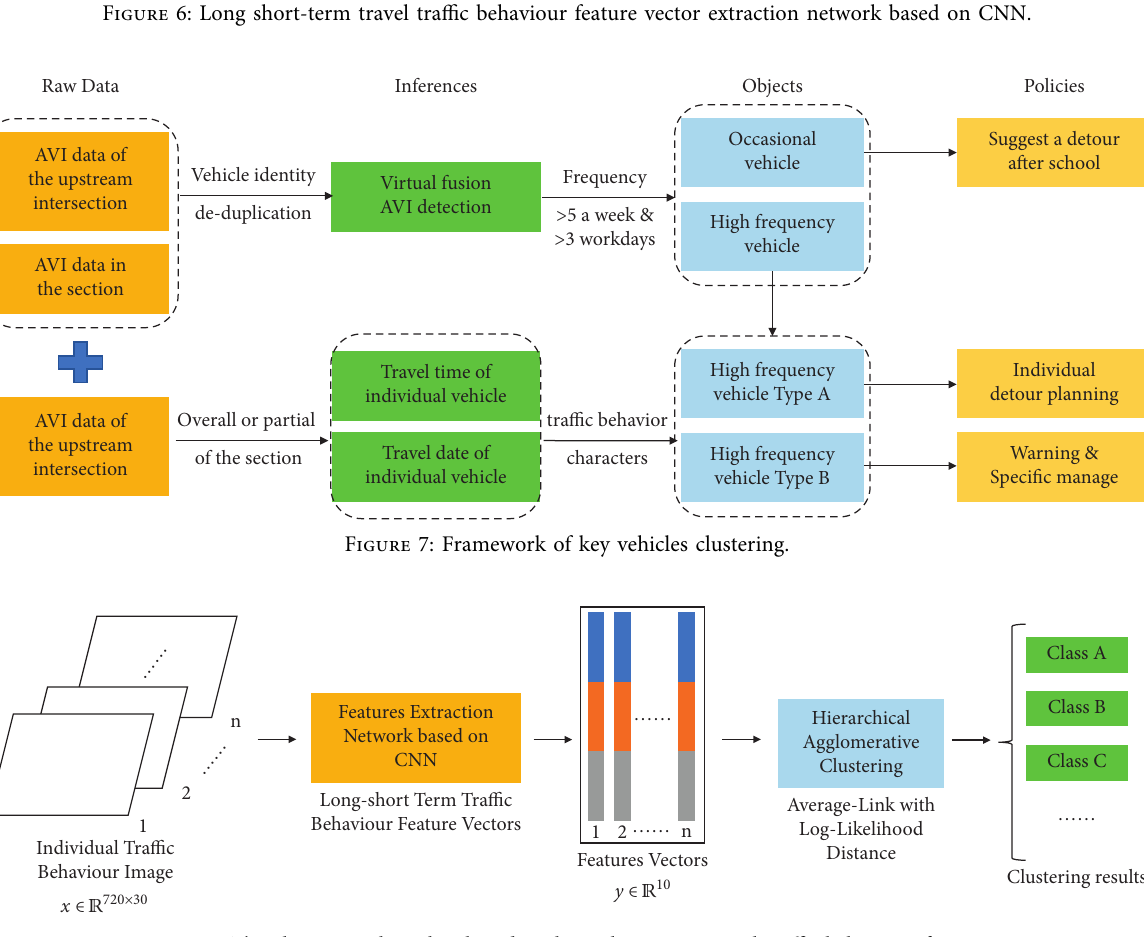
Figure 8: The clustering algorithm based on long short-term travel traffic behaviour